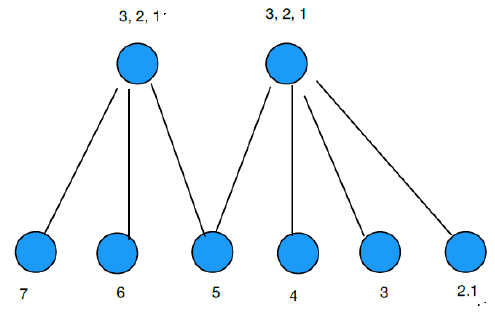
Figure 2. Buyer–seller